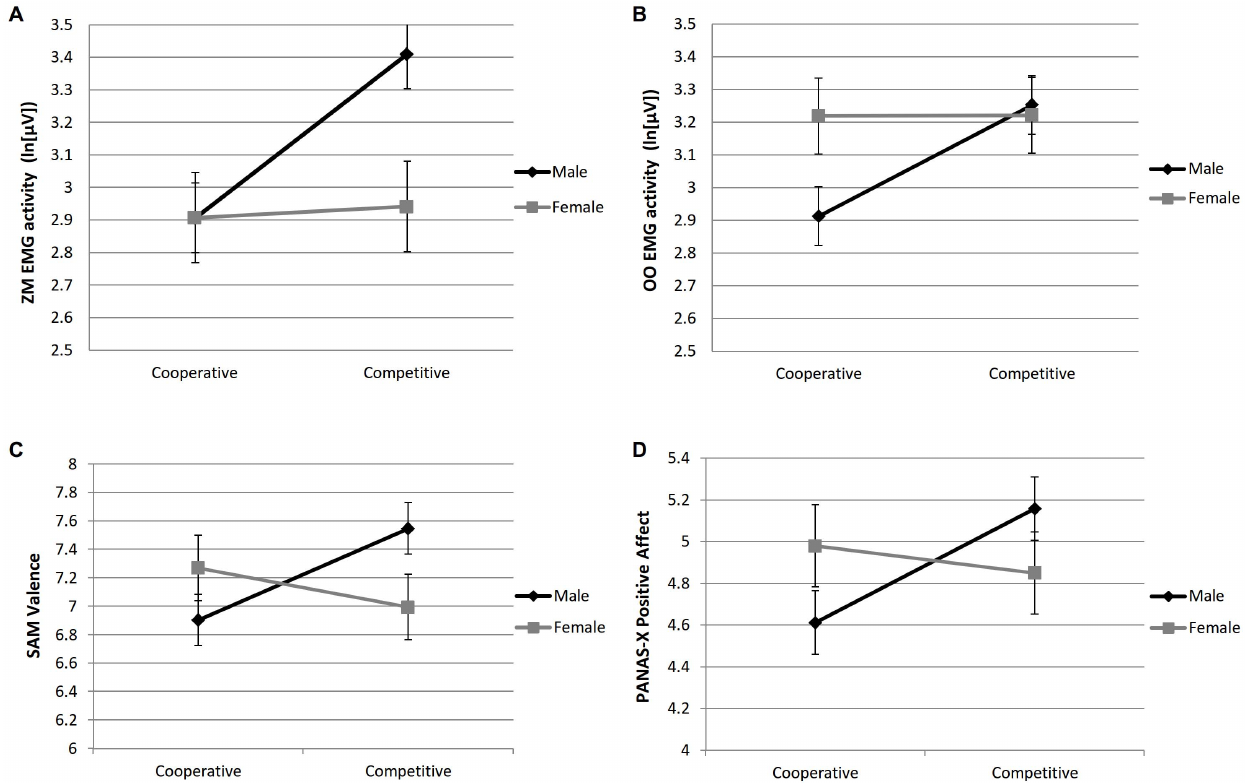
Figure 1. Gender differences in zygomaticus major (top left panel) and orbicularis oculi (top right) EMG activity, both associated with positive emotion, and self-reported pleasantness (bottom left) and positive affect (bottom right), across cooperative and competitive modes (Experiment 1). The error bars represent standard errors.